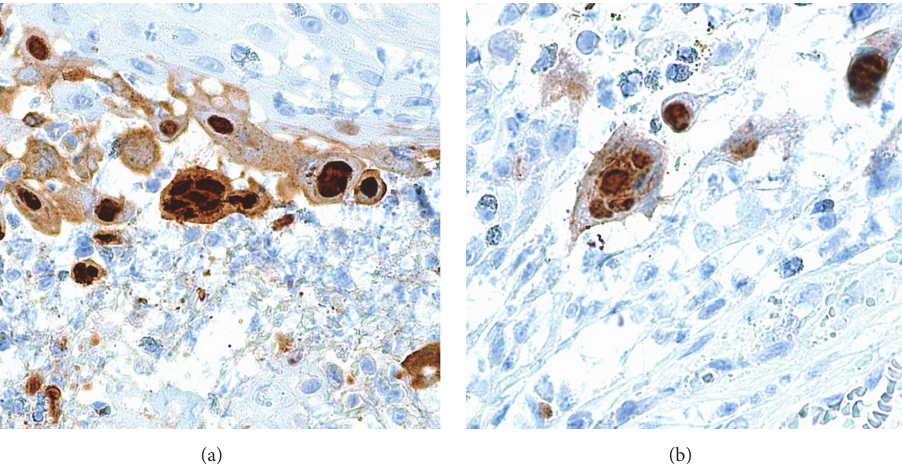
Figure 4: Cells from the biopsy specimen showing positive immunostaining for HSV-2 (a) and HSV-1 (b) (original magnification × 400).